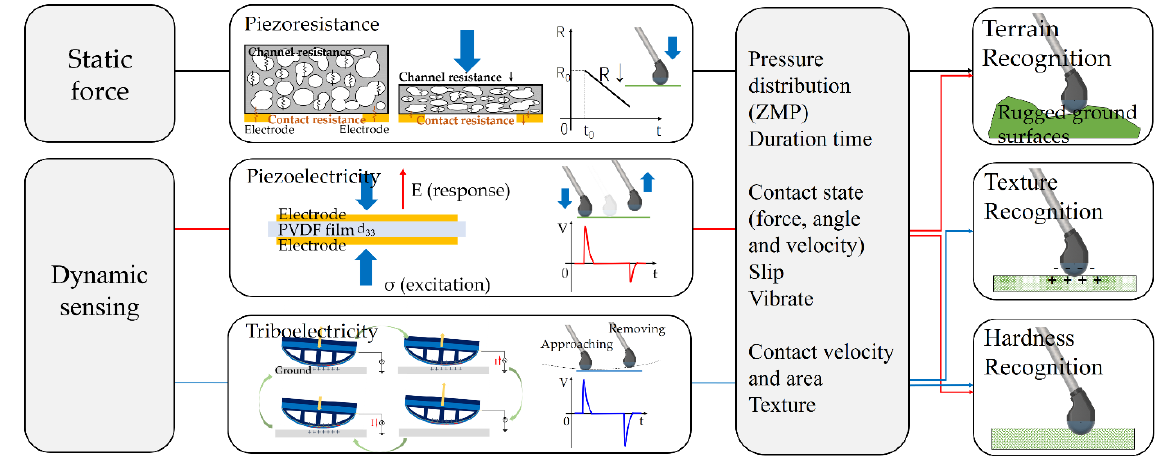
Figure 4. The principle of distinct signals generated from different ground contacts by the tri-modal sensor.